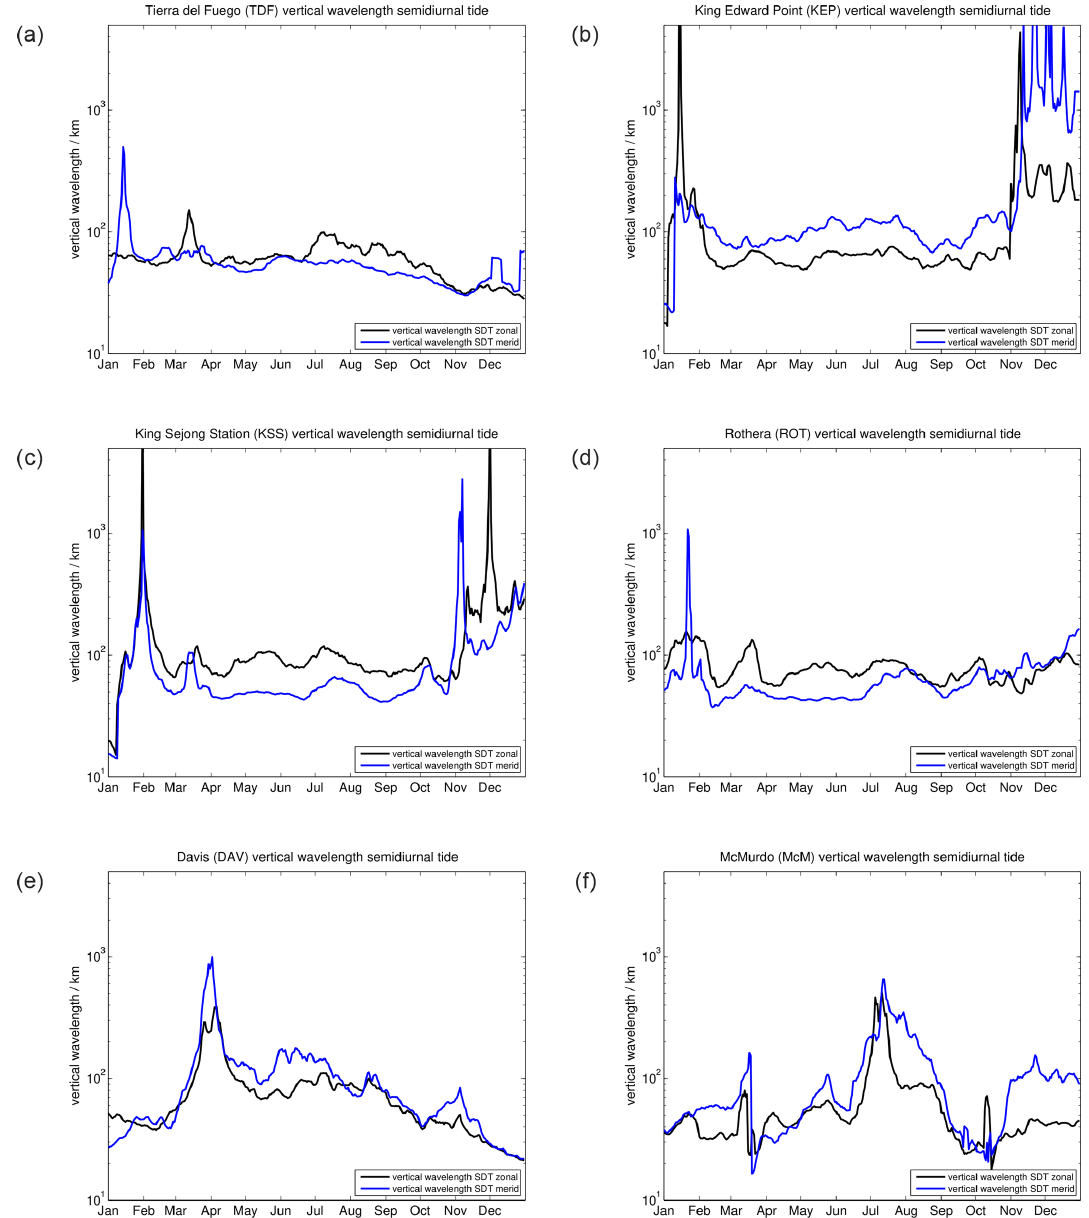
Figure 7. Comparison of semidiurnal tidal vertical wavelengths of (a) TDF, (b) KEP, (c) KSS, (d) ROT, (e) DAV, and (f)